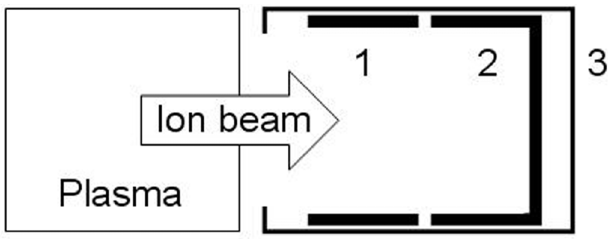
(cid:3) t (cid:4) : (1) nega- b